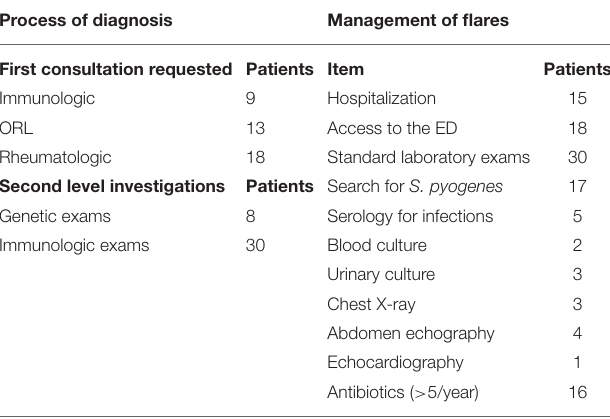
TABLE 2 | Investigations during the process of diagnosis and management of the disease flares. Process of diagnosis